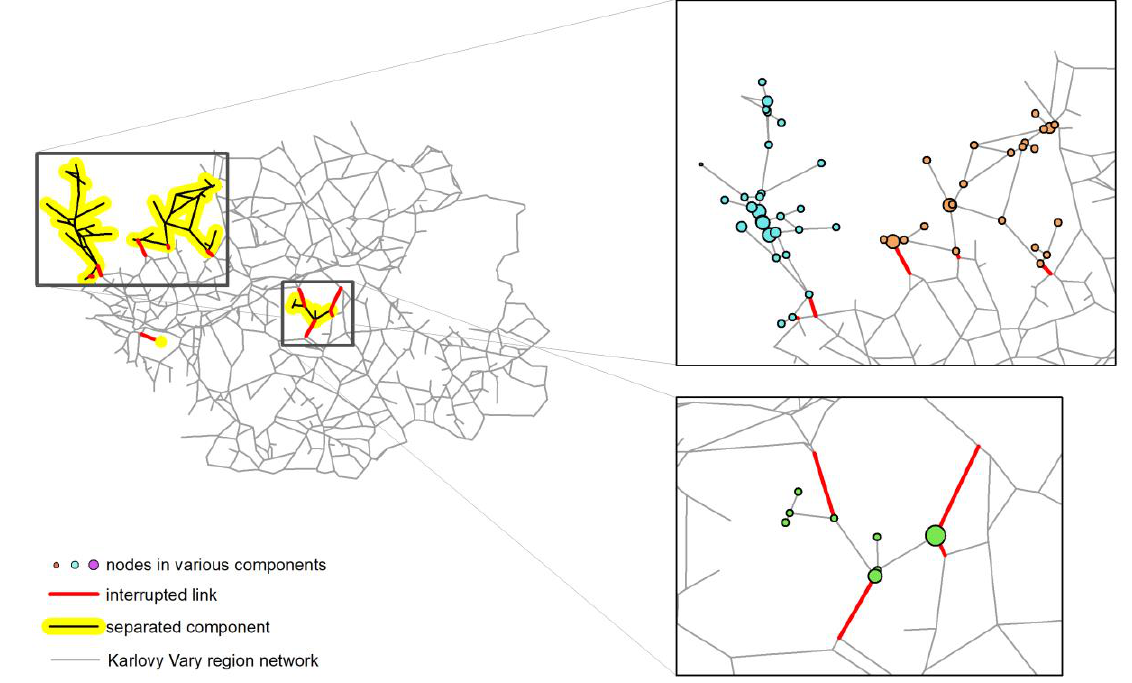
Figure 10. The worst scenario found by ANSA for ten concurrently interrupted road links in the Karlovy Vary region network. 82,427 people (22.48%) cut off from the main